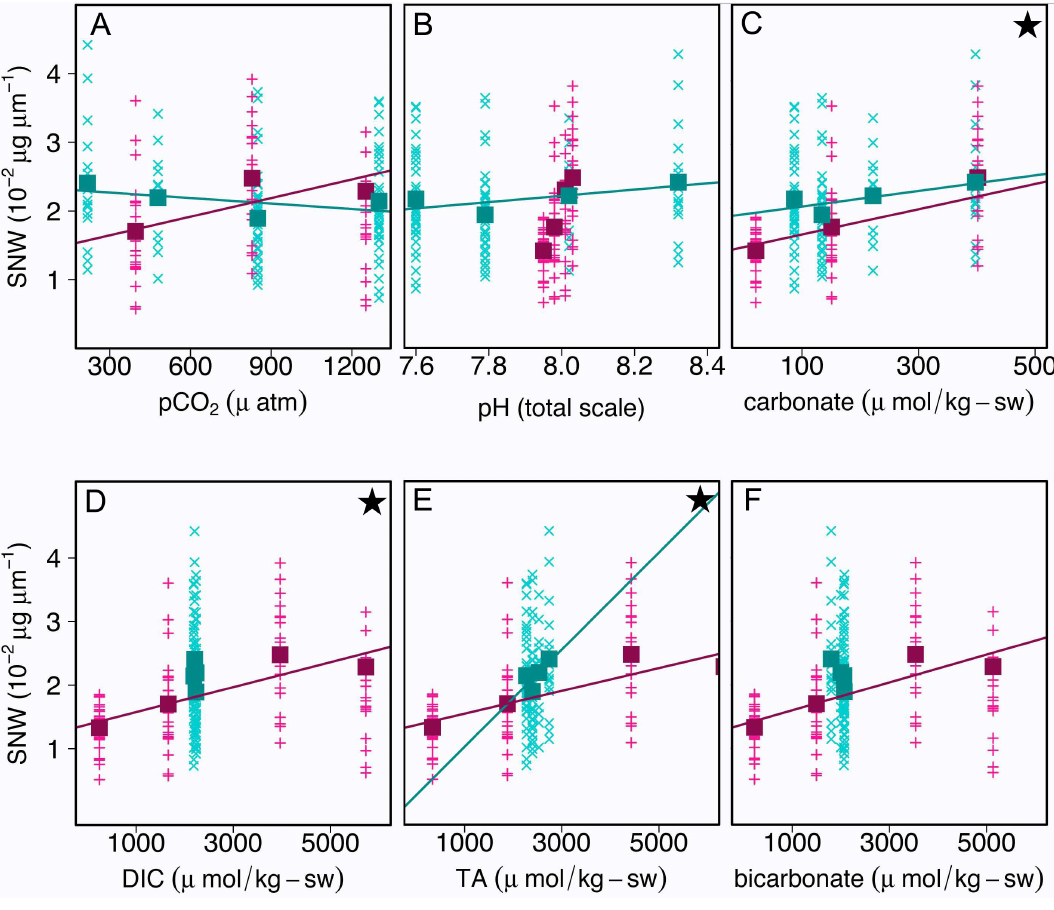
Fig. 2. SNW versus carbonate system parameters. Cyan x and pink + represent SNW of individual shells in the TA manipulation and the pH-stable manipulation, respectively. Closed squares in cyan and pink represent average SNW in the TA manipulation and the pH-stable manipulation, respectively. Cyan and pink lines represent linear regression lines for SNW versus the respective carbonate system parameter (TA- and pH-stable manipulation). Stars in the upper right corner represent a statistically significant (hoRS model, at p < 0 . 05) homogeneity of regression slopes. Due to the relatively small ranges in x axis, variations in some correlations (e.g., TA manipulation in D), the significance of regression slopes and thus the hoRS model is confined. Regression slopes have been omitted in these